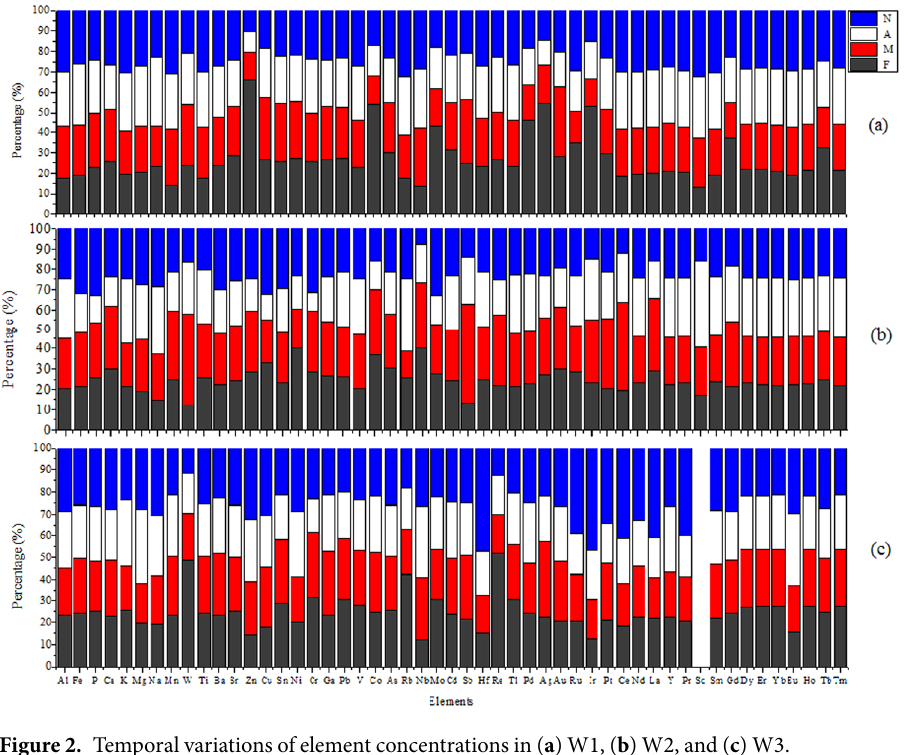
Figure 2. Temporal variations of element concentrations in ( a ) W1, ( b ) W2, and ( c ) W3.